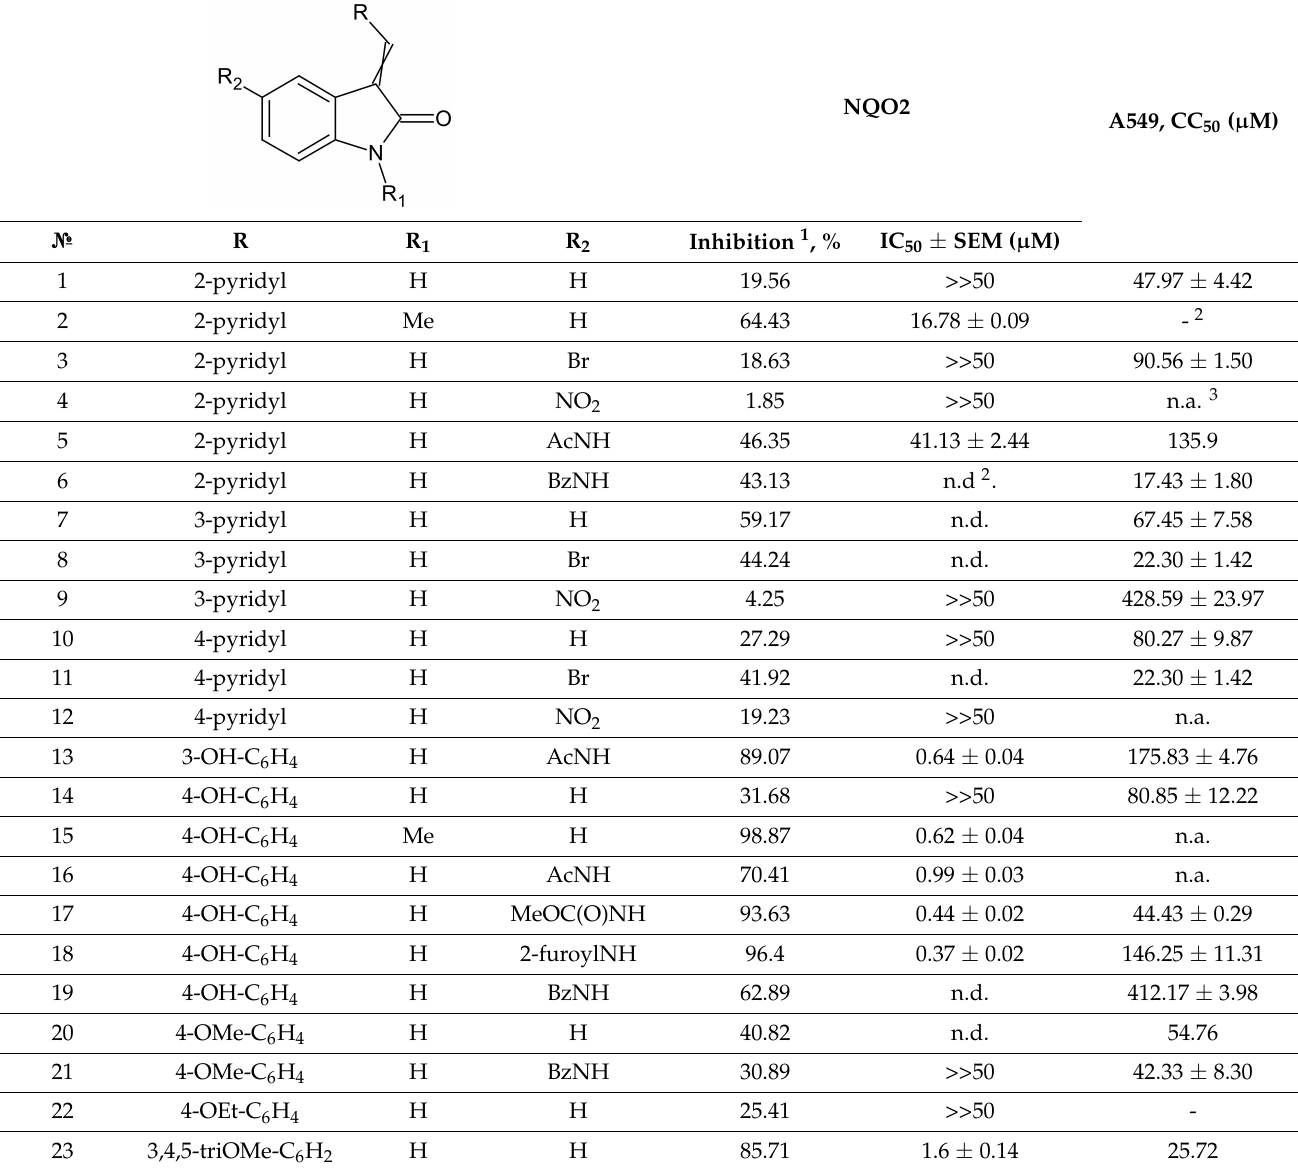
Table 4. Evaluation of enzyme inhibition activity and compound cytotoxicity against A549 cancer cell